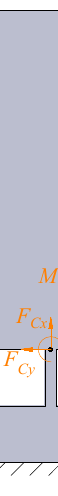
Figure 8. Static body analysis of the input